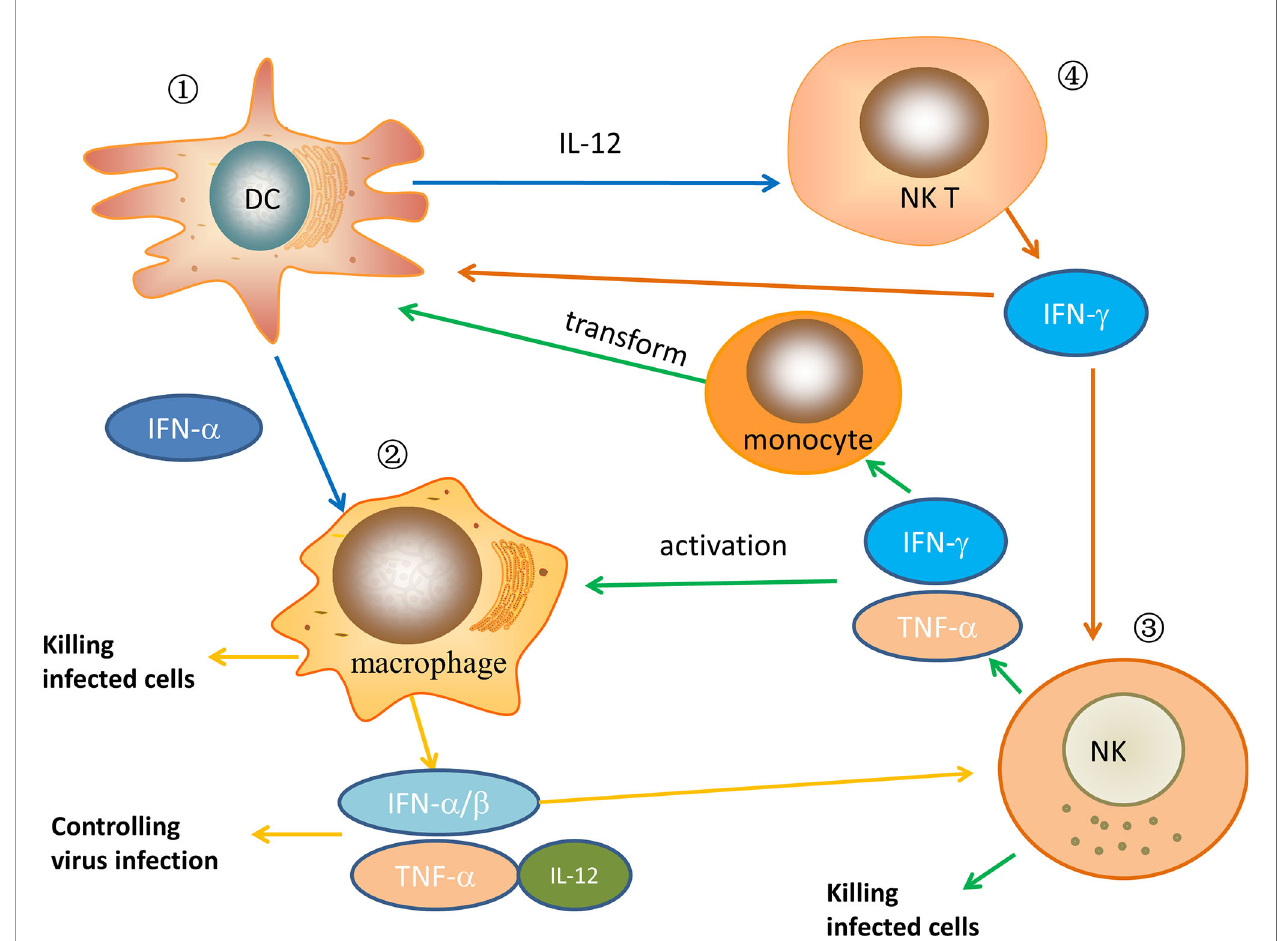
FIGURE 1 | The relationship of some major innate immune cells after HIV infection in ECs/LTNPs. ① In ECs/LTNPs, DCs are activated, the number of cells increases, and cytokines, such as IFN- a and IL-12, are secreted to play the role of antiviral infection. Meanwhile, these cytokines can activate macrophages and NKT cells. ② When macrophages are activated in ECs/LTNPs, the number of macrophages increases, and they have strong phagocytosis to infected cells. At the same time, the secretion of in fl ammatory cytokines such as IFN- a , IFN- b , TNF- a , and IL-12 increases, which control virus replication and activate NK cells. ③ When NK cells are activated in ECs/LTNPs, the number of cells increases and can directly kill infected cells. In the meantime, its cell activity increased, secreting IFN- g , TNF- a , which further activates macrophage and induces monocytes to transform into DCs. ④ After NKT cells are activated in ECs/LTNPs, the secretion of IL-2, IFN- g , and other cytokines increases, which further activate DCs and NK cells. In HIV-infected ECs or LTNPs, these immune cells jointly play an antiviral infection